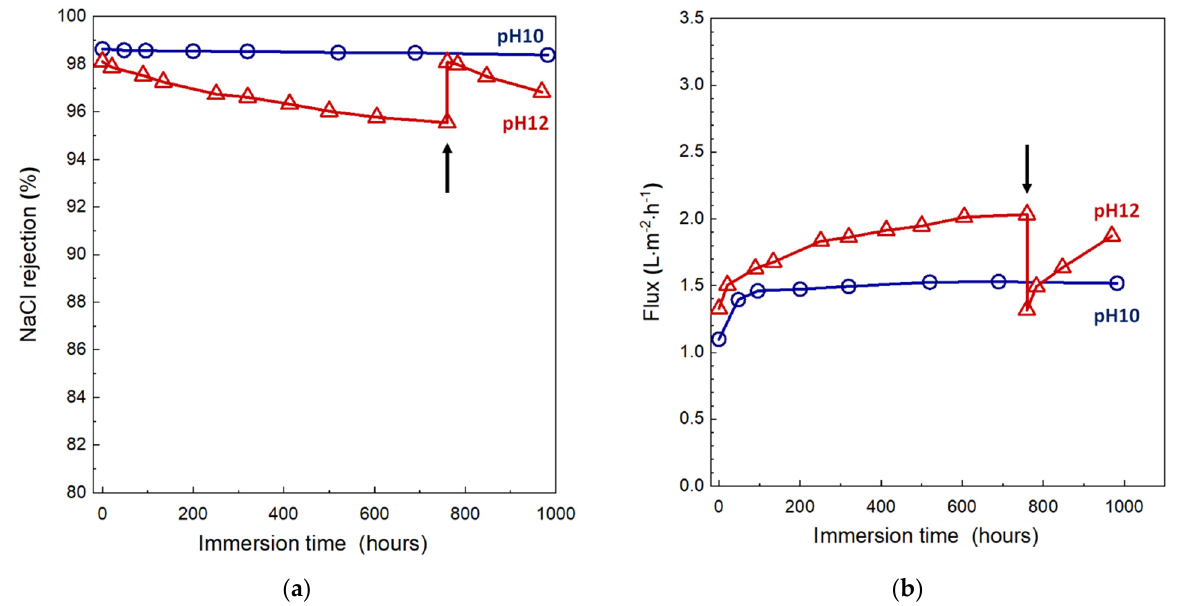
Figure 12. Alkaline resistance of the XCPVA-modified hollow-fiber membranes at pH 10 and 12: ( a ) NaCl rejection, ( b ) flux. The black arrows indicate the point at which LbL treatment was repeated.